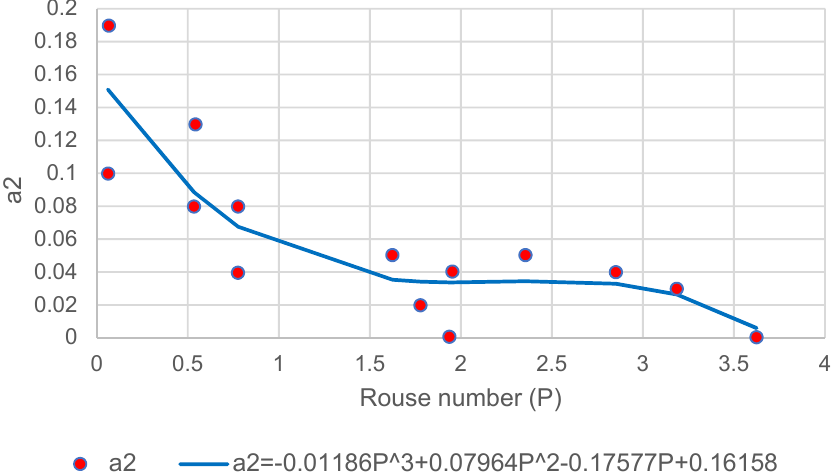
Figure 8. Rouse number regression vs. coefficient a 2 using decision trees ( R 2 = 0.7477 ).